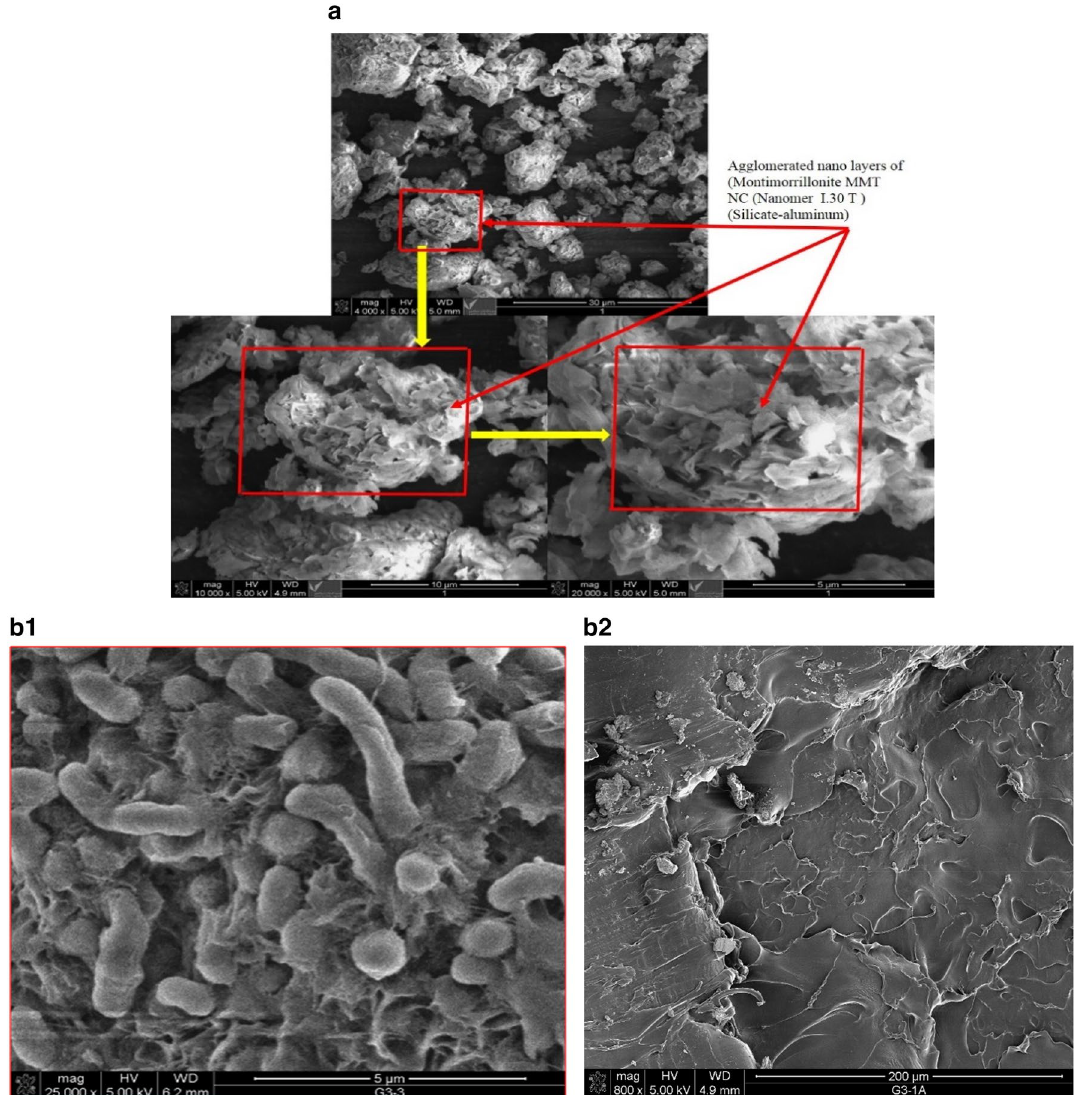
Figure 5. ( a ) SEM micrographs for MMT nanoclay layers before mixing with melted HDPE to produce CPNC. ( b1 ) SEM micrograph of nonmelted pure HDPE M40060 particles, showing polymer particle shapes before melting or mixing with MMT to produce CPNC. ( b2 ) SEM micrograph for melted pure HDPE. ( c ) SEM of CPNC (MMT and HDPE) showing the internal thickness and external nanostructure surface, homogeneity and nanoclay–polymer bond: (1) internal structure and fibre orientation, (2) thickness and layers, and (3) external surface of the sample. ( d ) SEM micrographs of CPNC mortar showing the homogenous microstructure of bonded sand and melted CPNC. ( e ) SEM micrographs of CPNC concrete showing the microstructure of bonded sand and aggregate with melted